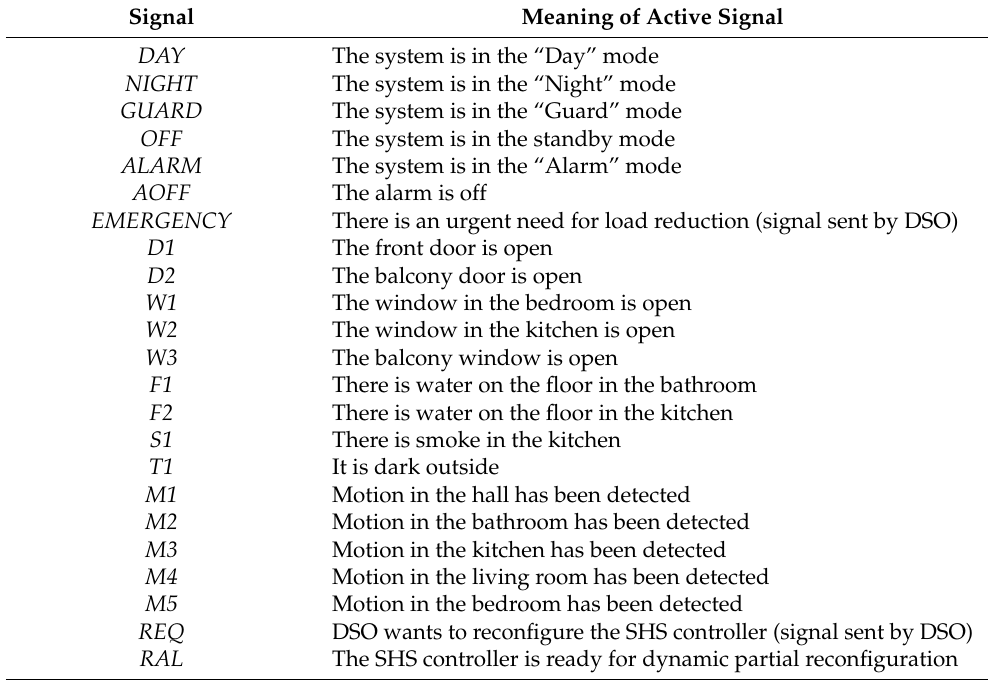
Table A1. The meanings of the SHS